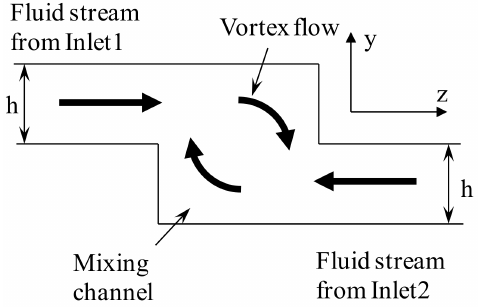
Figure 1. Basic schematic of the idea of vortex micro T-mixer. The two inlet channels of the vortex micro T-mixer are joining the mixing channel at an offset position. The height of the inlet channels is half the height of the mixing channel (h = H/2). The two fluid streams from Inlet 1 and Inlet 2 enter the channel at an offset position and create a vortex